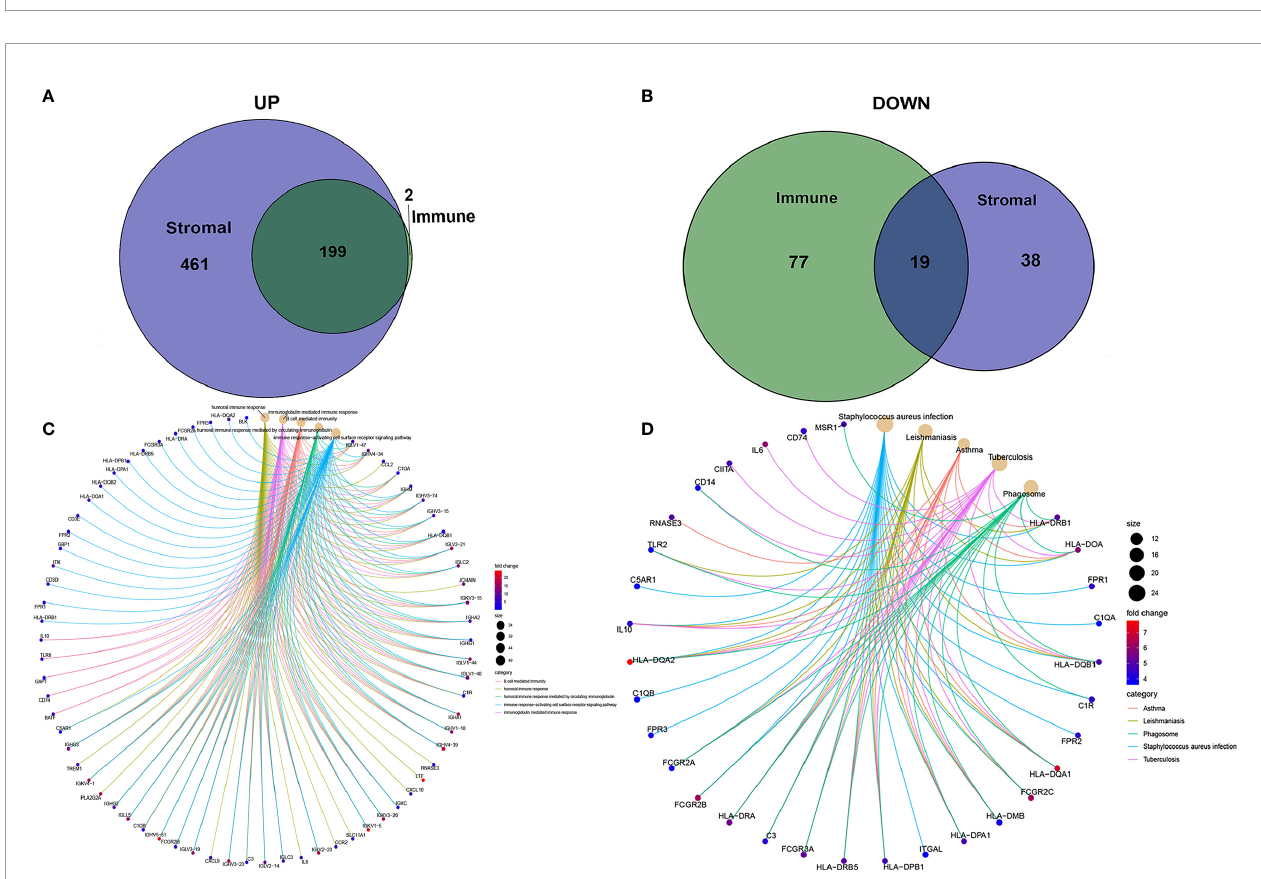
FIGURE 5 | Up-regulated and down-regulated and enrichment analysis of GO and KEGG. (A, B) Venn plots showing common up-regulated and down-regulated DEGs shared by ImmuneScore and StromalScore. (C, D) GO and KEGG enrichment analysis for